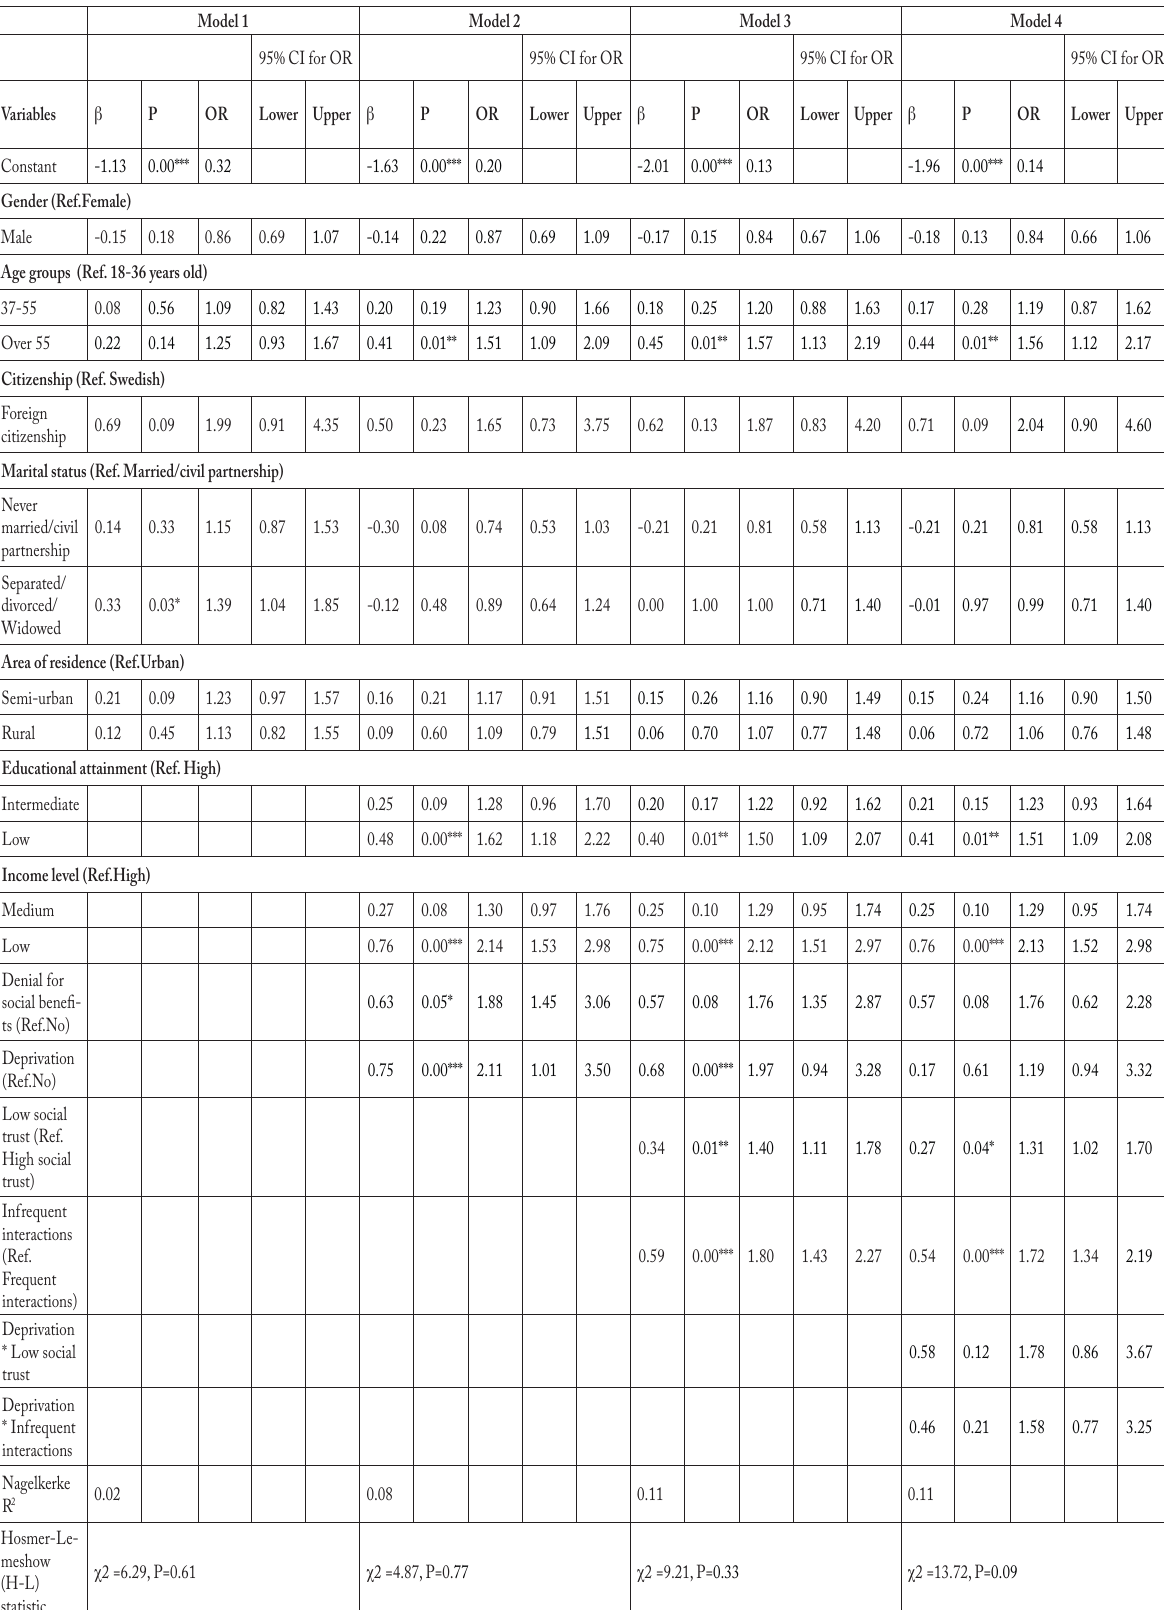
Table 2. Binary logistic regression analysis for predicting poor self-rated health in Sweden ( n =